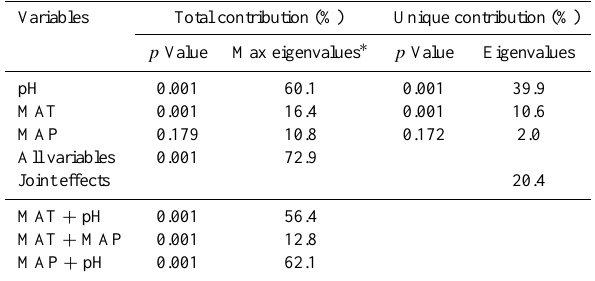
Table 1. Results of RDA and pRDA showing the total and unique contributions of soil pH, MAT and MAP to the variance in brGDGT distributions in the QTP soils.